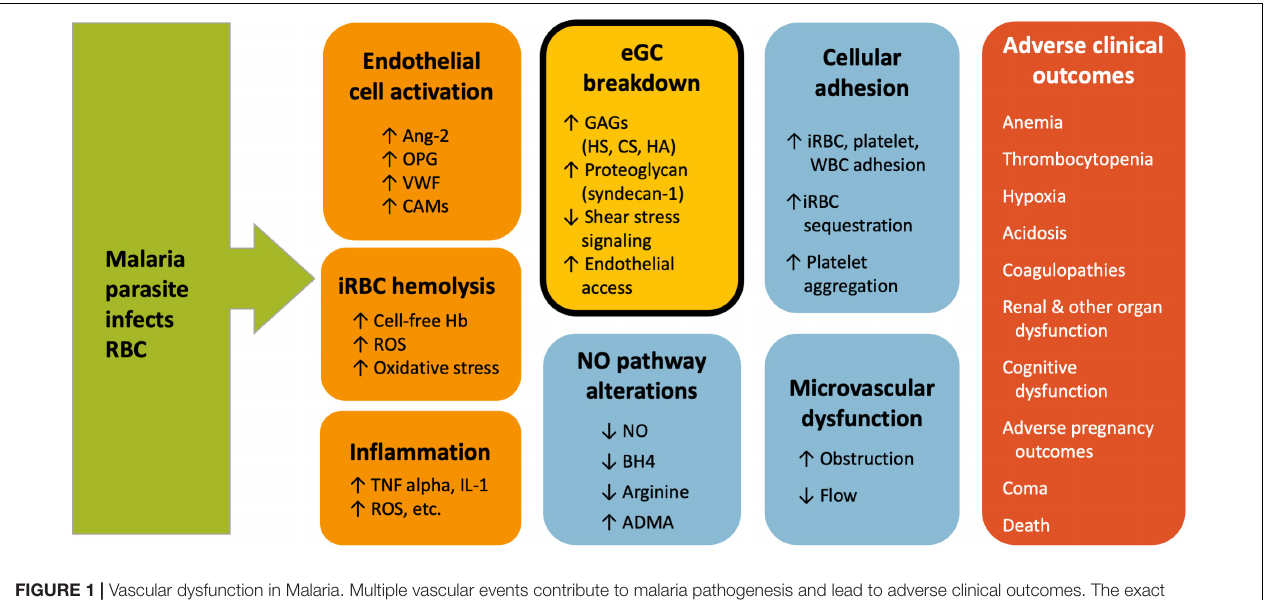
FIGURE 1 | Vascular dysfunction in Malaria. Multiple vascular events contribute to malaria pathogenesis and lead to adverse clinical outcomes. The exact mechanism and sequence of events is not known, but early events include endothelial cell activation and rupture of infected RBC. These lead to endothelial glycocalyx breakdown, reduced NO, cellular adhesion and microvascular dysfunction. Endothelial glycocalyx breakdown (shown in the gold, bolded box) is associated with multiple markers of malaria disease severity and may play a central role in different aspects of malaria pathogenesis. ADMA, asymmetric dimethylarginine; Ang-2, angiopoietin-2; BH4, tetrahydrobiopterin; CAMs, cell adhesion molecules; CS, chondroitin sulfate; eGC, endothelial glycocalyx; GAG, glycosaminoglycan; Hb, hemoglobin; HA, hyaluronic acid; HS, heparan sulfate; iRBC, infected red blood cell; NO, nitric oxide; OPG, osteoprotegerin; ROS, reactive oxygen species; S1P, sphingosine-1-phosphate; VWF, von Willebrand